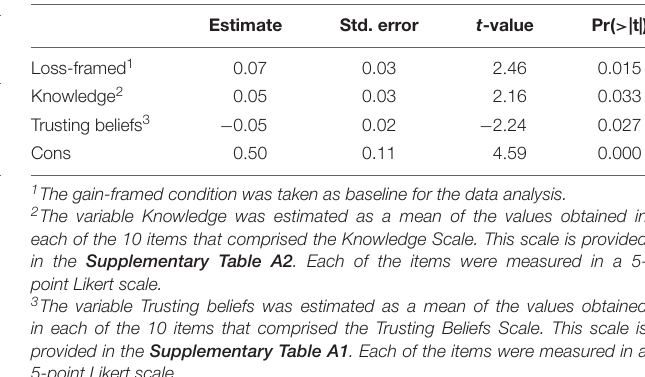
TABLE 8 | Estimated coefficients of the final model for cybersecure